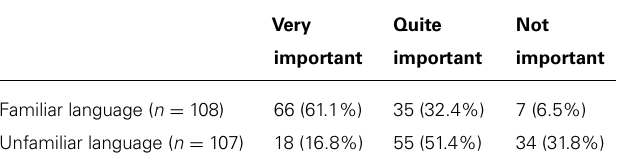
Table 1 | Numbers and percentages of respondents indicating different levels of importance for understanding texts in familiar and unfamiliar